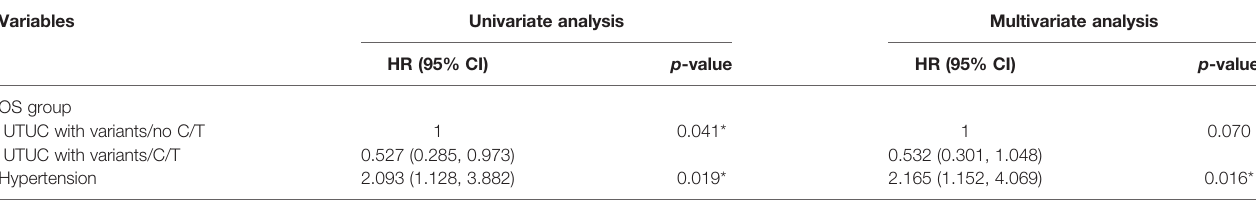
TABLE 3 | Univariate and multivariate regression overall survival (OS) analyses in patients with variant upper tract urothelial cancer (UTUC) undergoing radical nephroureterctomy (RNU).